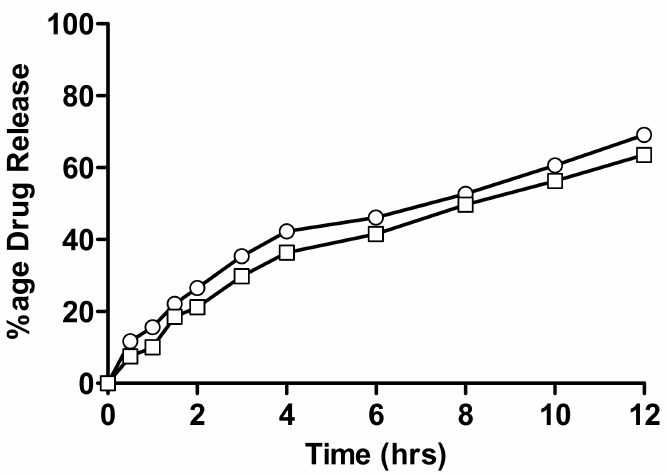
Figure 9. Percentage release of nicorandil with varying crosslinker concentration; (